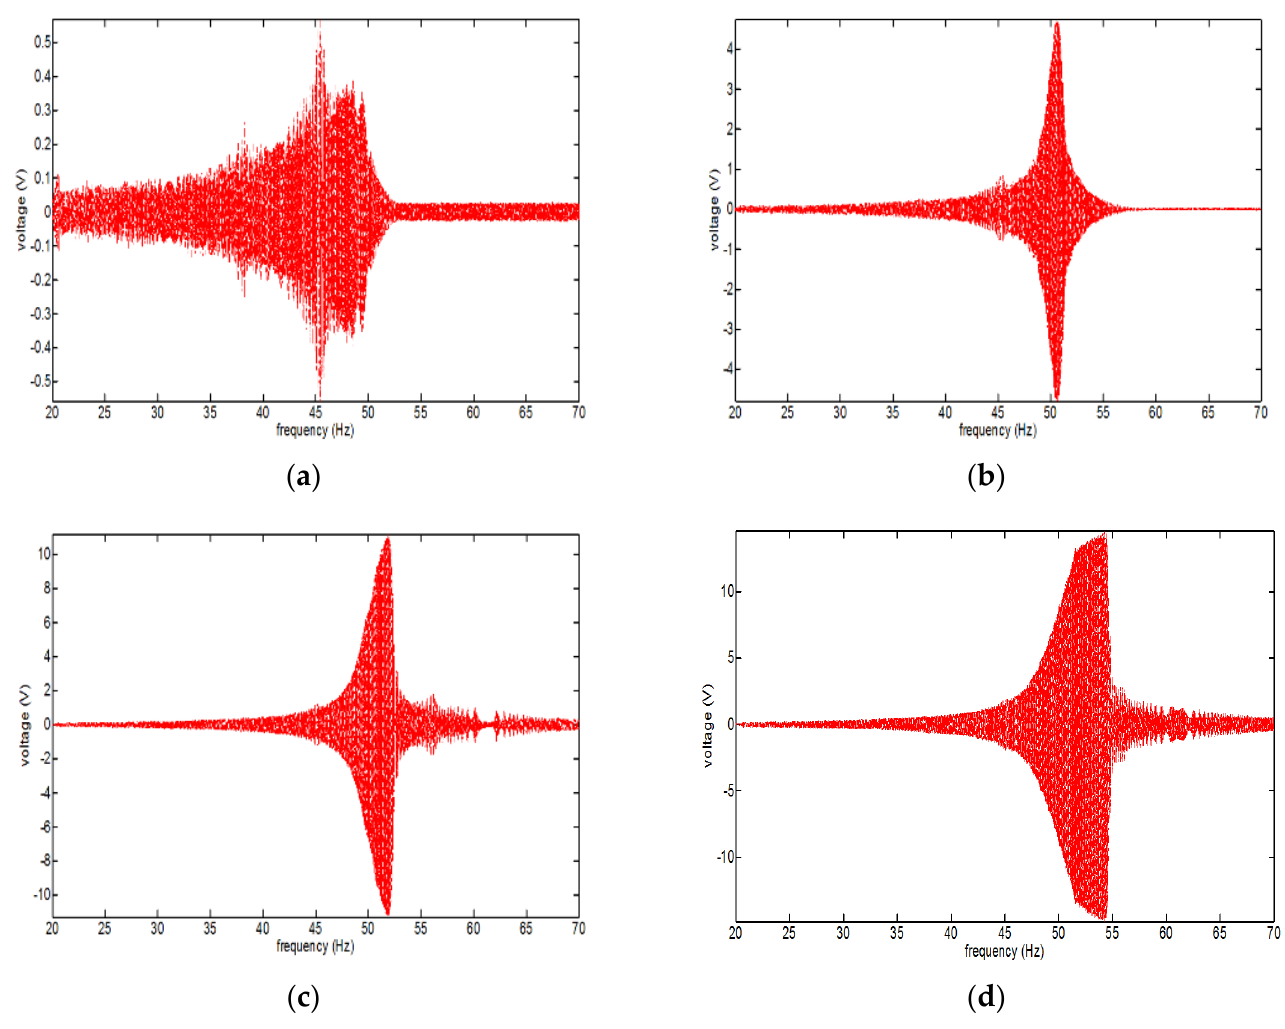
Figure 11. Performance test of the magnetic spring vibration ‐ energy ‐ harvesting device in the laboratory based on the magnitude of the external vibration acceleration: ( a ) 0.5 G vibration acceleration; ( b ) 1.0 G vibration acceleration; ( c ) 1.5 G vibration acceleration; ( d ) 2.0 G vibration acceleration. Table 5. Maximum generated power with a 360 ‐Ω load resistance (P exp ‐ veh ) at one lower coil of the magnetic spring vibration ‐ energy ‐ harvesting device. The maximum moving displacement of the spring was 7 mm.